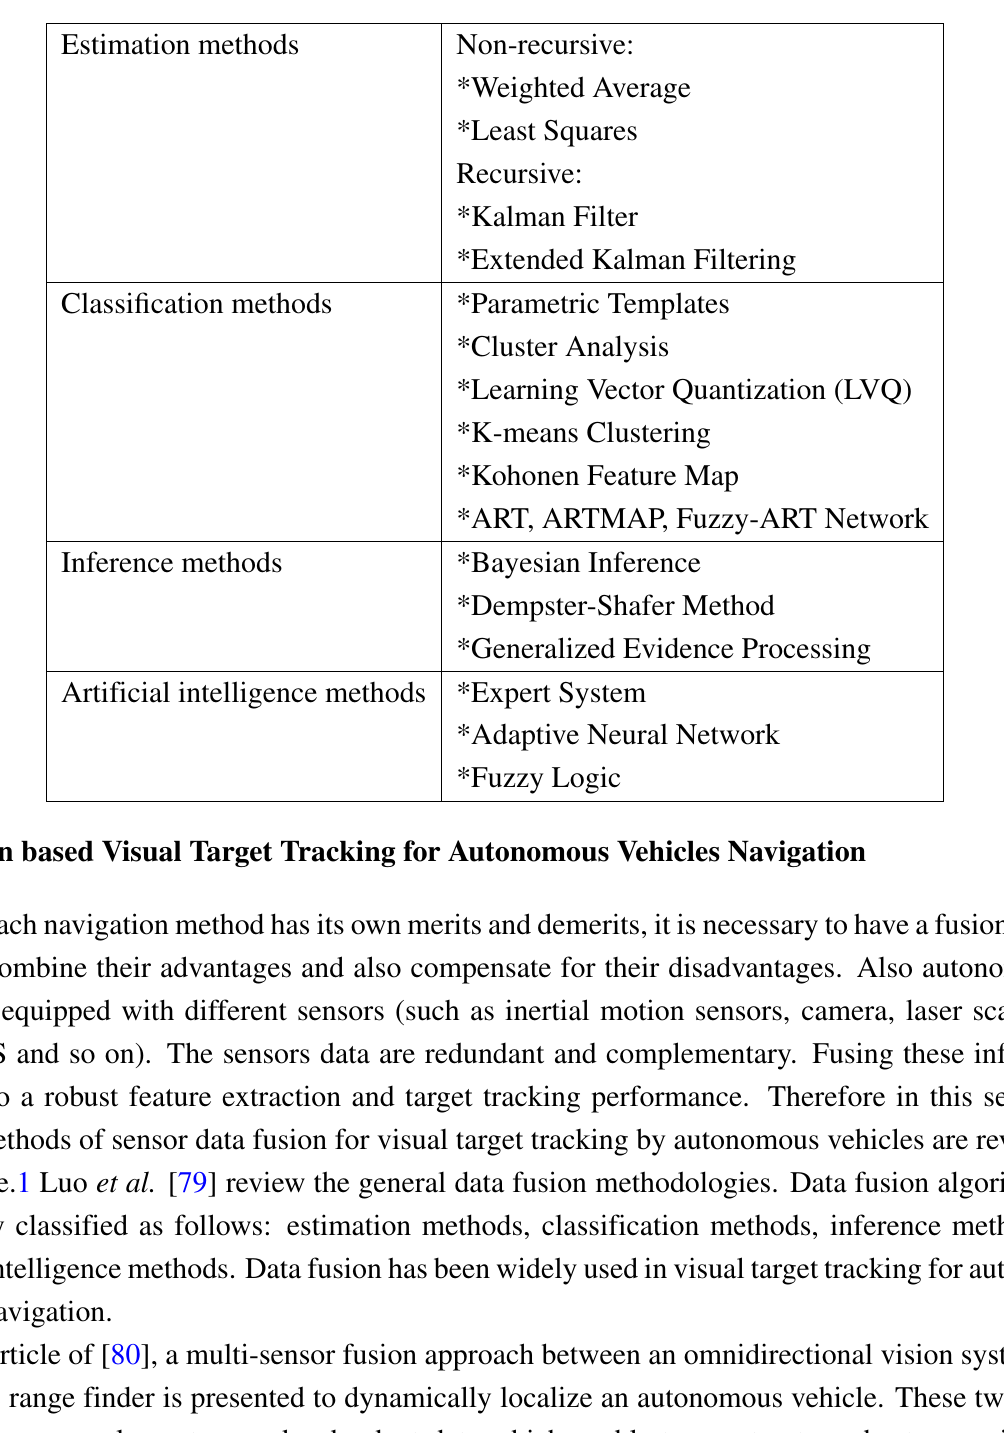
Table 1. The Classification of Data Fusion Algorithms from